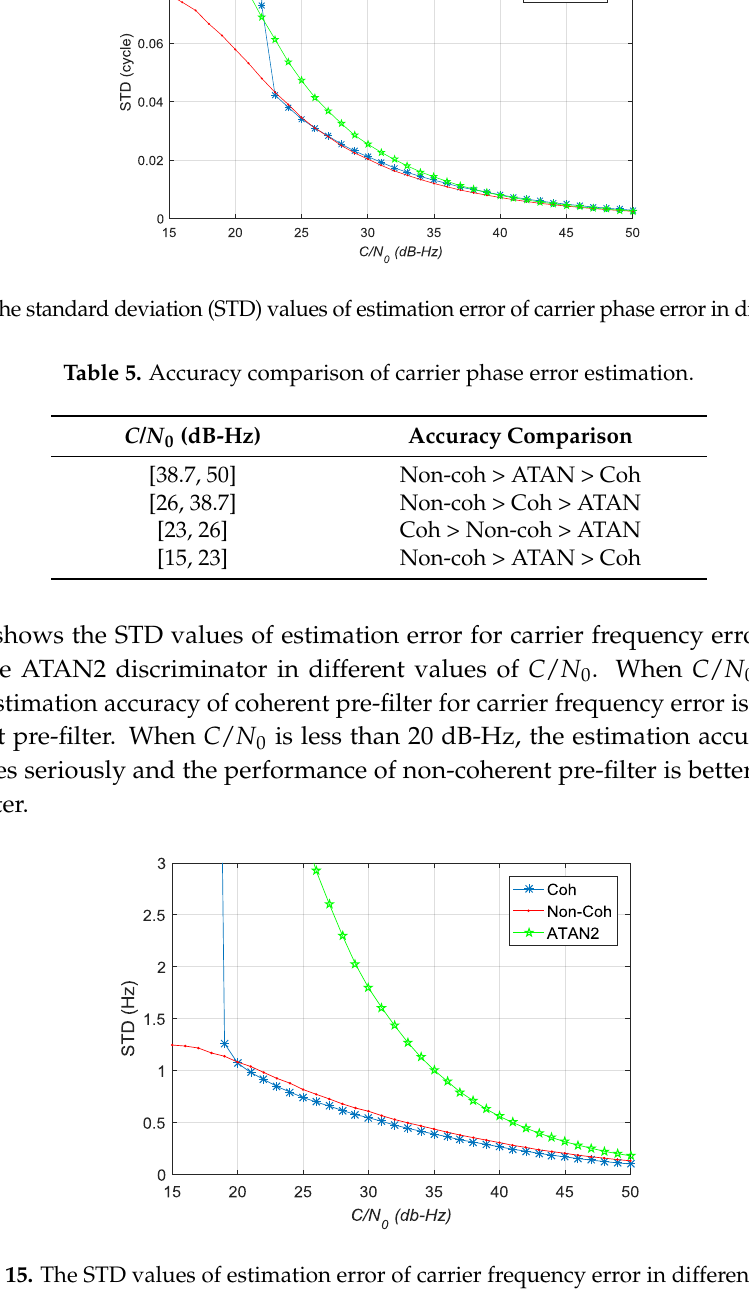
Figure 16. The STD values of estimation error of code phase error in different C / N 0 . Overall, the tracking error estimated by coherent/non-coherent pre-filter is less noisy than that estimated by the ATAN/ATAN2/NC-EMLE discriminator. The non-coherent pre-filter outperforms the coherent pre-filter for tracking error estimation in weak signal or highly dynamic scene. The non- coherent pre-filter also outperforms the coherent pre-filter for carrier phase error estimation in strong signal condition. 5. Conclusions and Future Work This paper presents an enhanced non-coherent pre-filter design. Firstly, the observation noise variance of non-coherent pre-filter is analyzed through Monte Carlo Simulation. The LUTs are subsequently created to store the relationship among T coh , C / N 0 , and the estimation noise variances of the ATAN/ATAN2/NC-EMLE discriminator. The LUTs provide a method to set the observation noise variance matrix of non-coherent pre-filter correctly according to estimated C / N 0 . Secondly, a simple FDE structure is introduced to overcome the inherent deficiency of the ATAN discriminator, whose outputs are observations of the non-coherent pre-filter. Through the FDE structure, the effective estimation range of the non-coherent pre-filter for carrier phase error extends from (−0.25 cycle, 0.25